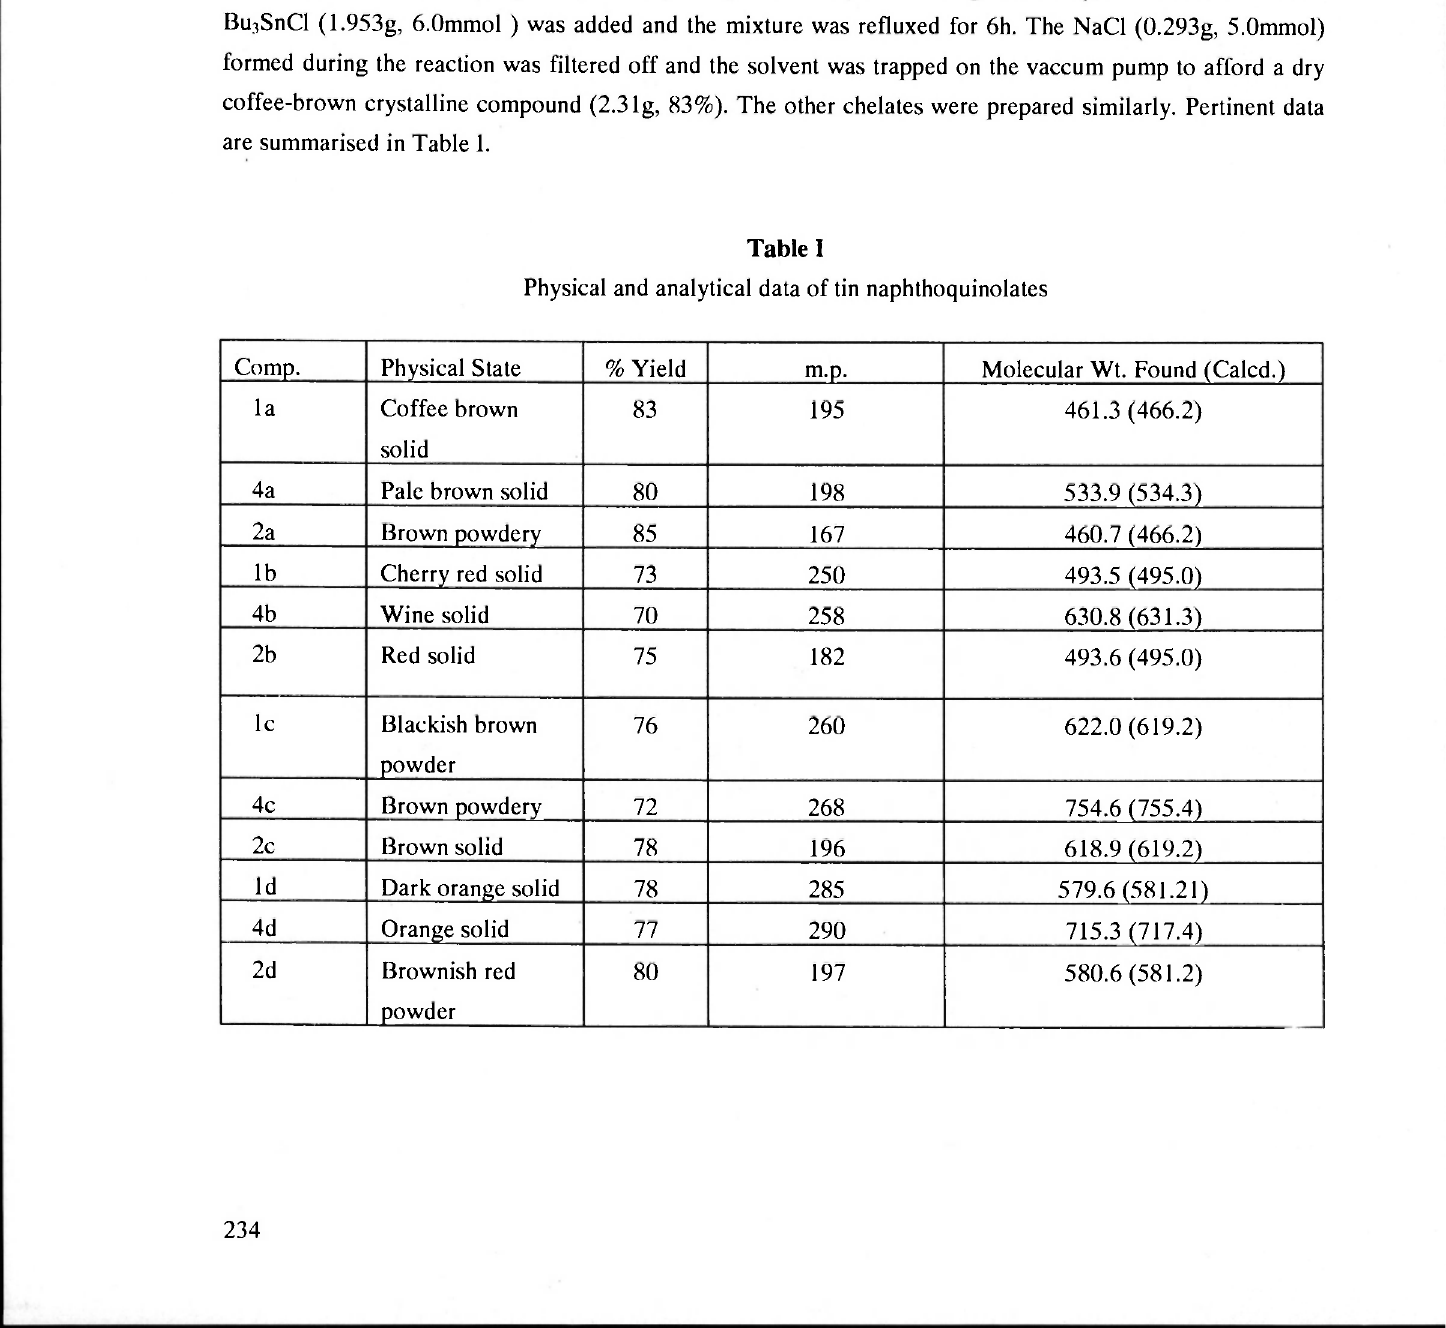
Physical and analytical data of tin naphthoquinolates